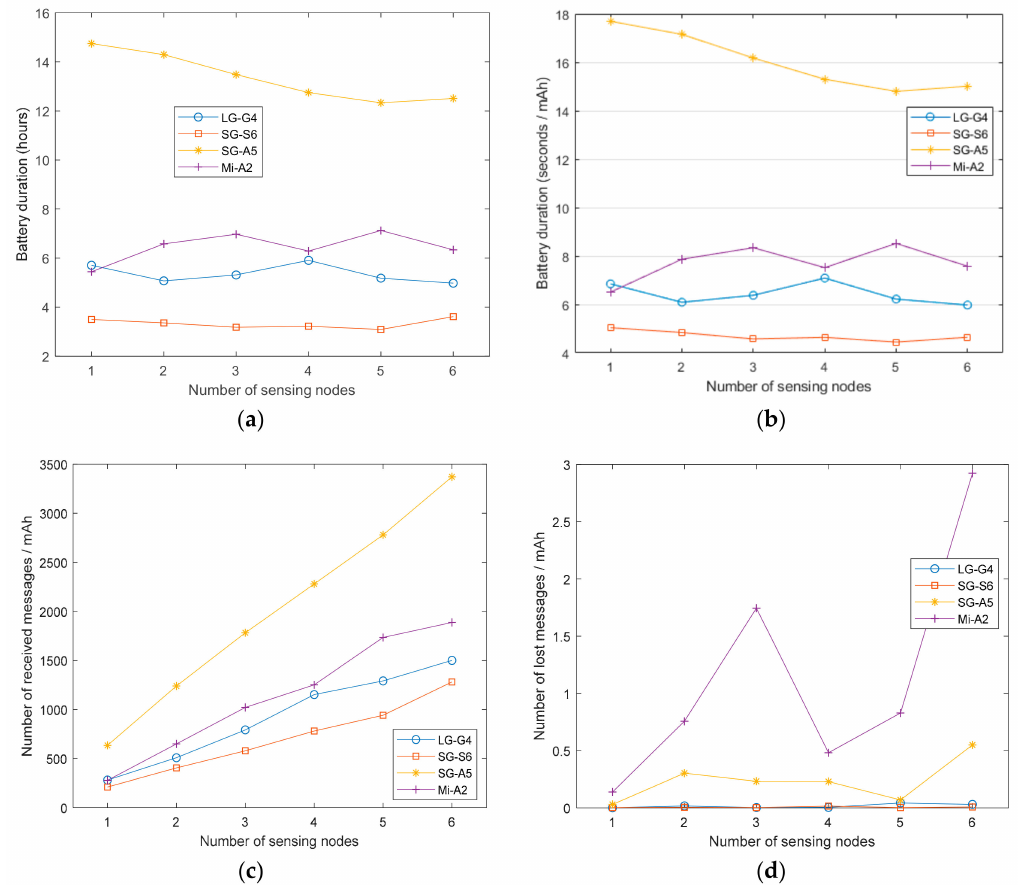
Figure 5. Performance metrics as a function of the number of connected sensors for a sampling rate of 50 Hz when Wi-Fi is enabled to retransmit the received data to an external server: ( a ) Battery duration; ( b ) relative battery lifetime (lifespan per consumed mAh); ( c ) number of messages received per consumed mAh; ( d ) number of lost messages per consumed